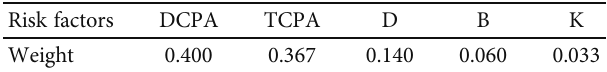
Figure 6: The grey cloud whitenization weight function. (a) The function of lower measure. (b) The function of moderate measure. (c) The function of upper measure. (d) The AGC whitenization weight function. Table 4: Indicator weights of CRI